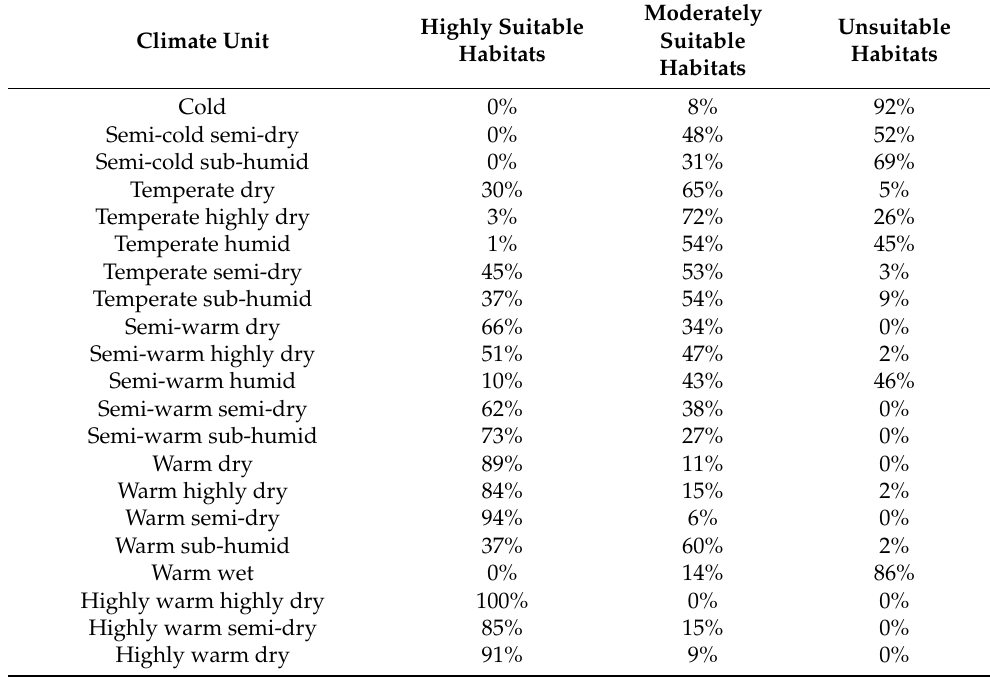
Table 1. Results of the overlapping between the occurrence probability map of buffelgrass under the current climate and the map of the climate units of Mexico. For each climate unit, the table indicates the percent cover of habitats with highly suitable climatic conditions (occurrence probabilities above 0.5), moderately suitable climatic conditions (occurrence probabilities between 0.1 and 0.5), and unsuitable climatic conditions (occurrence probabilities below 0.1) for